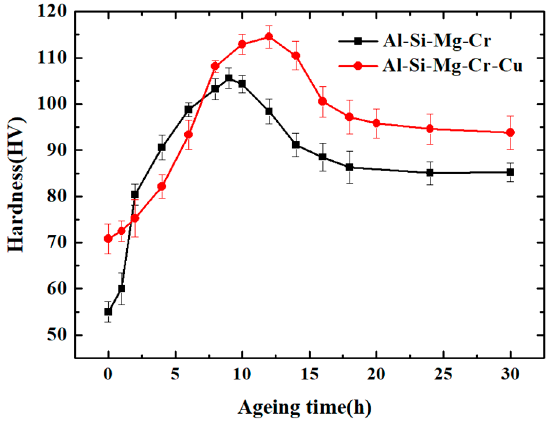
Figure 1. Ageing curves of Al-7%Si-0.3%Mg-0.3%Cr alloy and Al-7%Si-0.3%Mg-0.3%Cr-1.5%Cu al- loys .